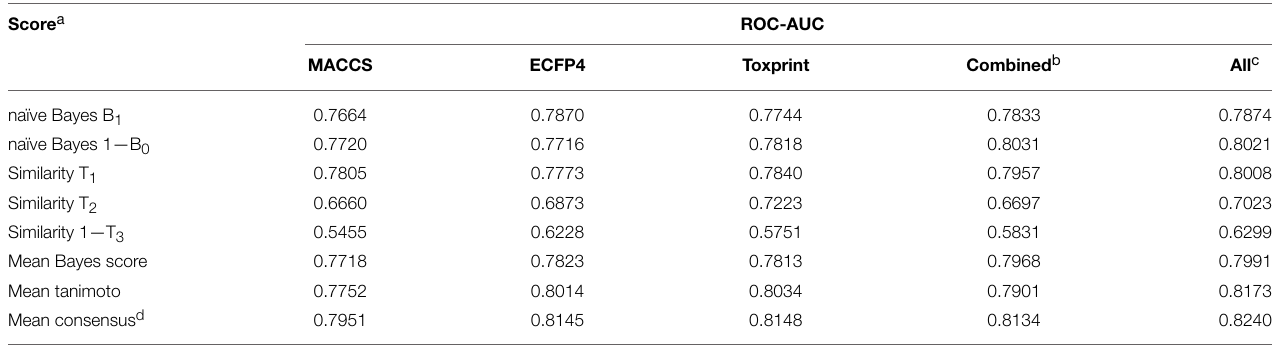
TABLE 1 | Performance of different fingerprints in cross-validation of predictions for